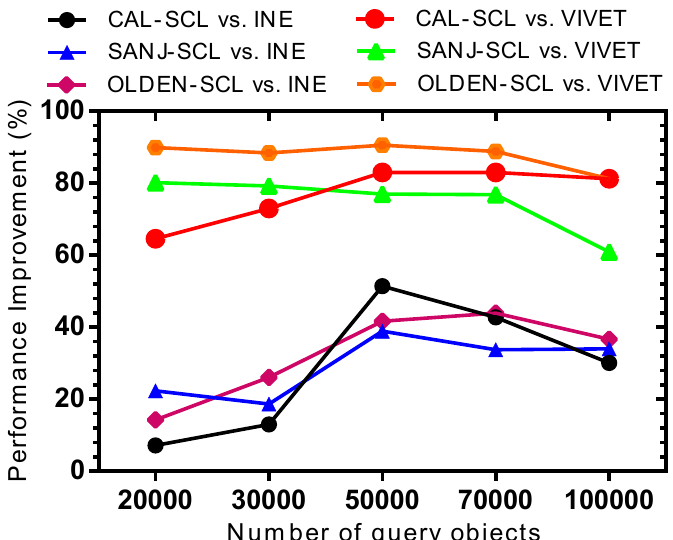
Figure 11. Performance improvement by increasing the query object size following (cid:104) U , U (cid:105)